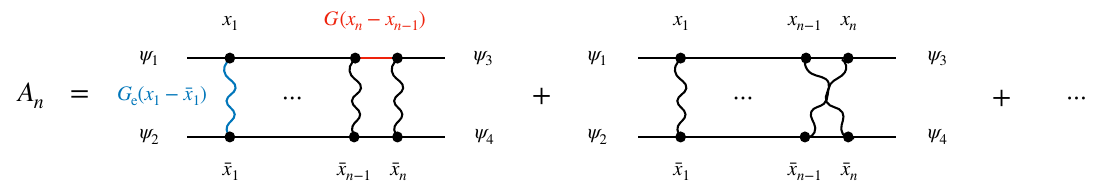
Figure 1 . Contributions from ladder diagrams involving n t -channel exchanges to the scattering of 4